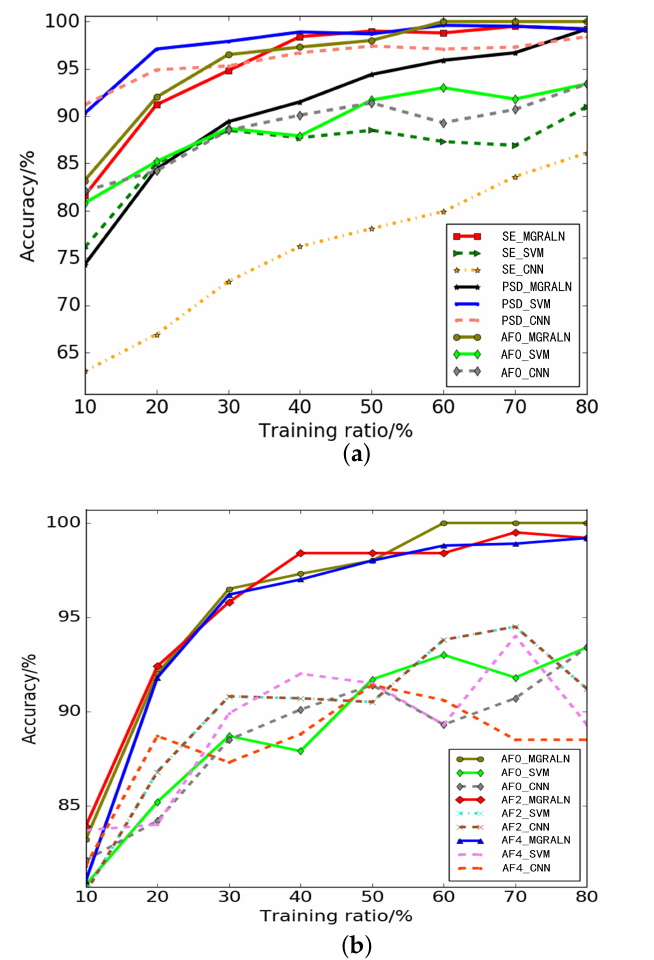
Figure 9. Accuracy comparisons of MGRALN with SVM and CNN when training ratio varies from 10% to 80%. ( a ) Represents recognition results of MGRALN when transformation is SE, PSD or AF0, and ( b ) represents recognition results of MGRALN with different AF